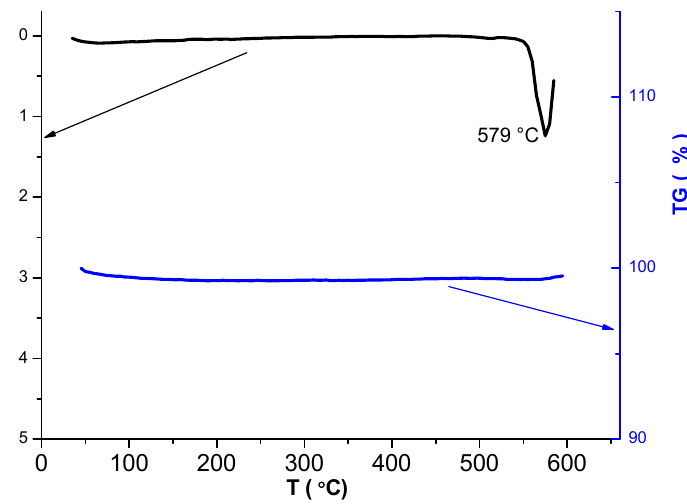
Figure 2. DSC and TG curves for NaV 3 O 8 .